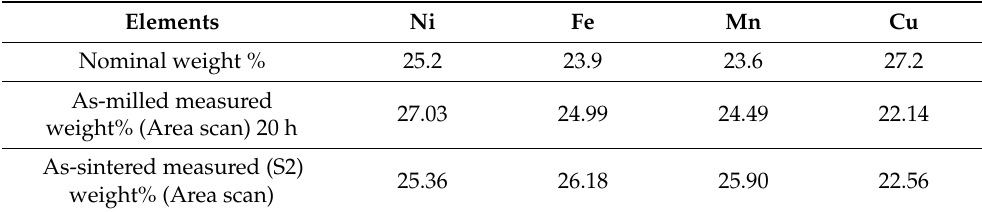
Table 4. Comparison of nominal and measured weight proportion of the as-milled and the as-sintered NiMnFeCu.